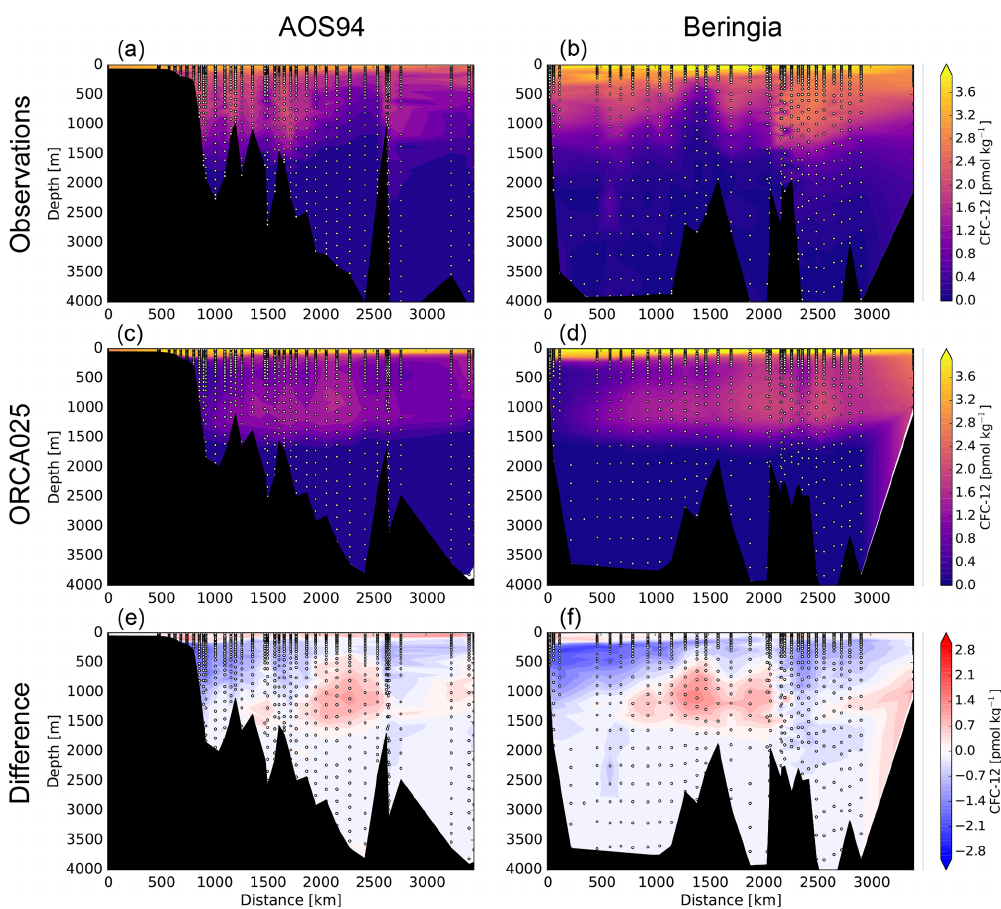
Figure 6. CFC-12 concentrations along the AOS94 section (a, c, e) and the Beringia section (b, d, f) for the observations (a, b) , the simulated summer means in ORCA025 (c, d) , and the model–data difference (e, f)